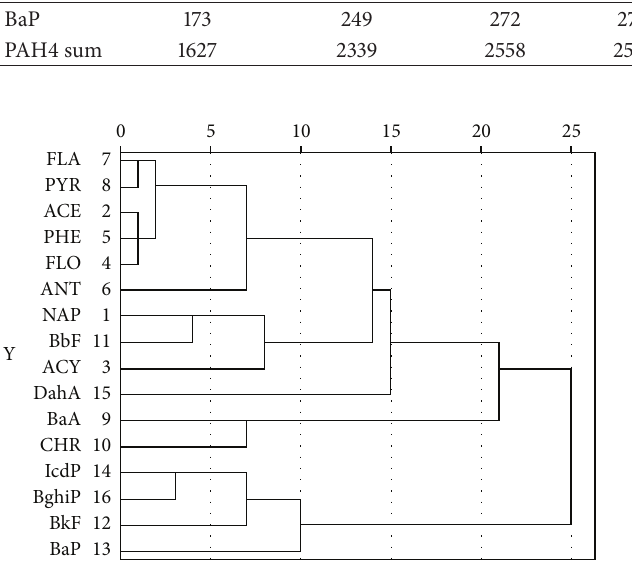
Figure 4: Clustering tree of PAH concentration in